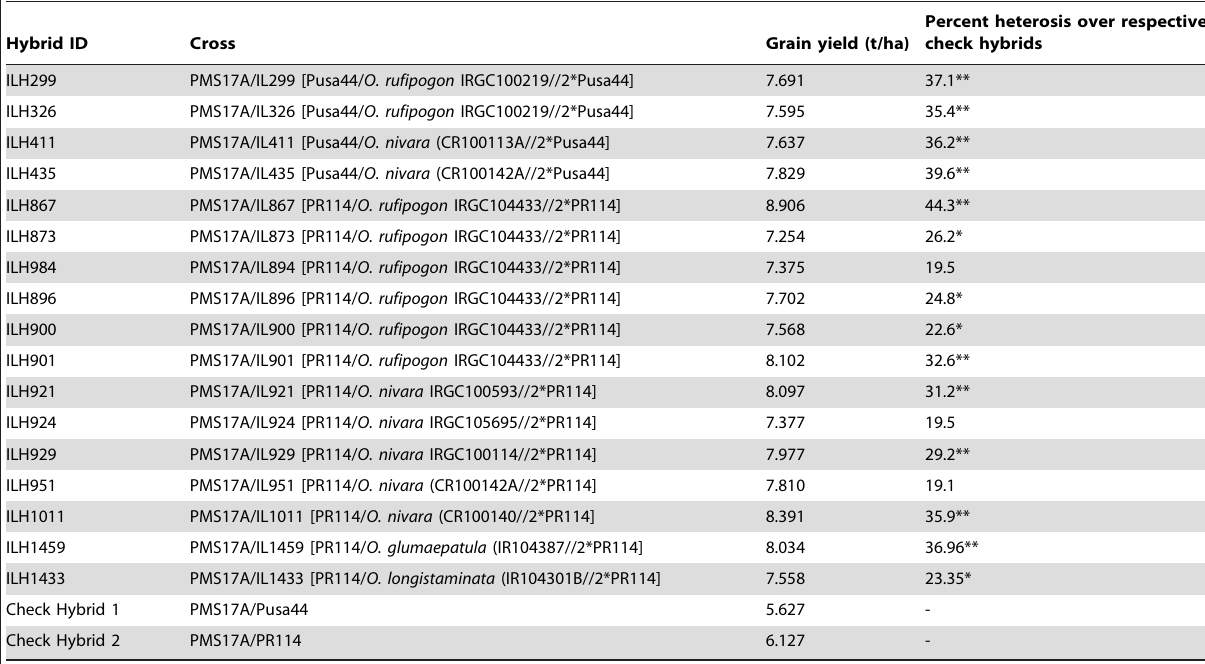
Table 1. Mean grain yield and standard heterosis of 17 ILHs evaluated in the year 2008.